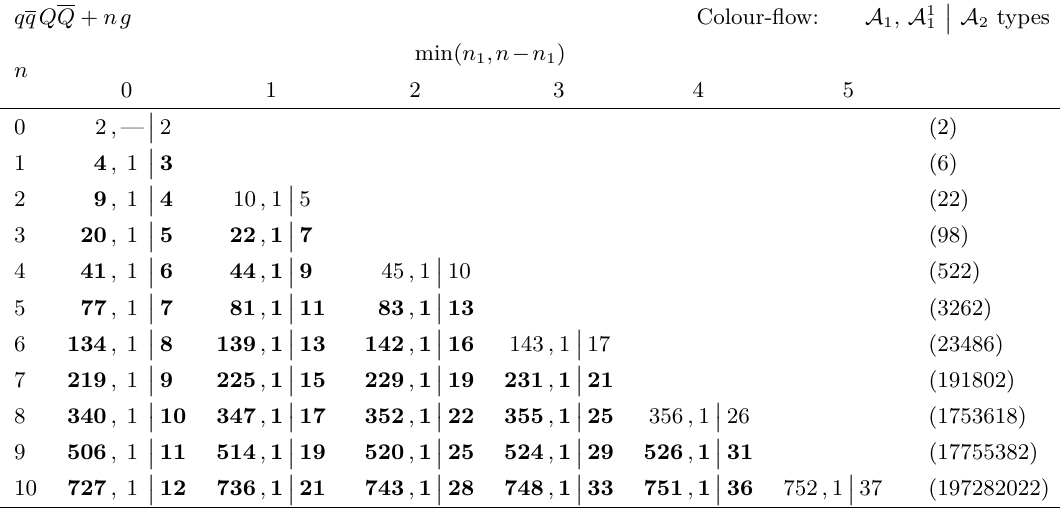
) 1 , n − n 1 and n − n as defined in 1 1 , A 1 and, after 1 1